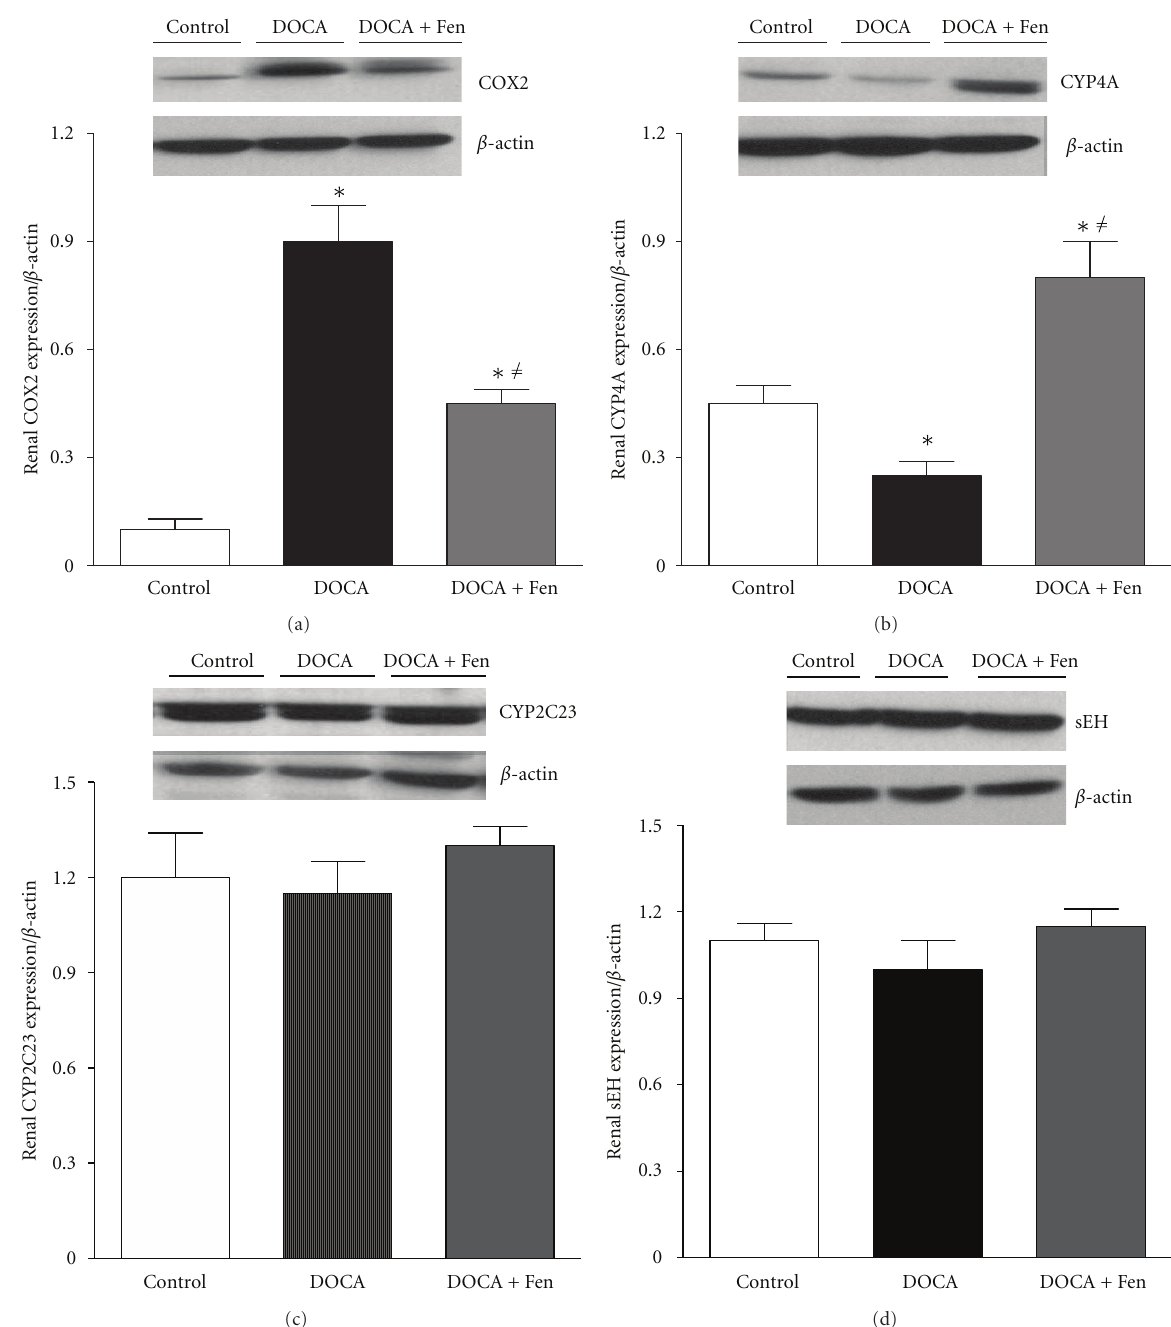
Figure 4: Western blot expression and analysis of (a) COX-2, (b) CYP4A, (c) CYP2C23, and (d) sEH in whole-kidney homogenates taken from control, DOCA, and DOCA + fenofibrate mice ( ∗ indicates DOCA + fenofibrate significantly reduced COX-2 expression when compared to DOCA alone. / = indicates DOCA + fenofibrate COX-2 expression was significantly higher than the control group. ∗ indicates DOCA and DOCA + fenofibrate have significantly di ff erent renal CYP4A expression when compared to control. / = indicates DOCA + fenofibrate renal expression of CYP4A is significantly increased when compared to DOCA ( P < 0 .